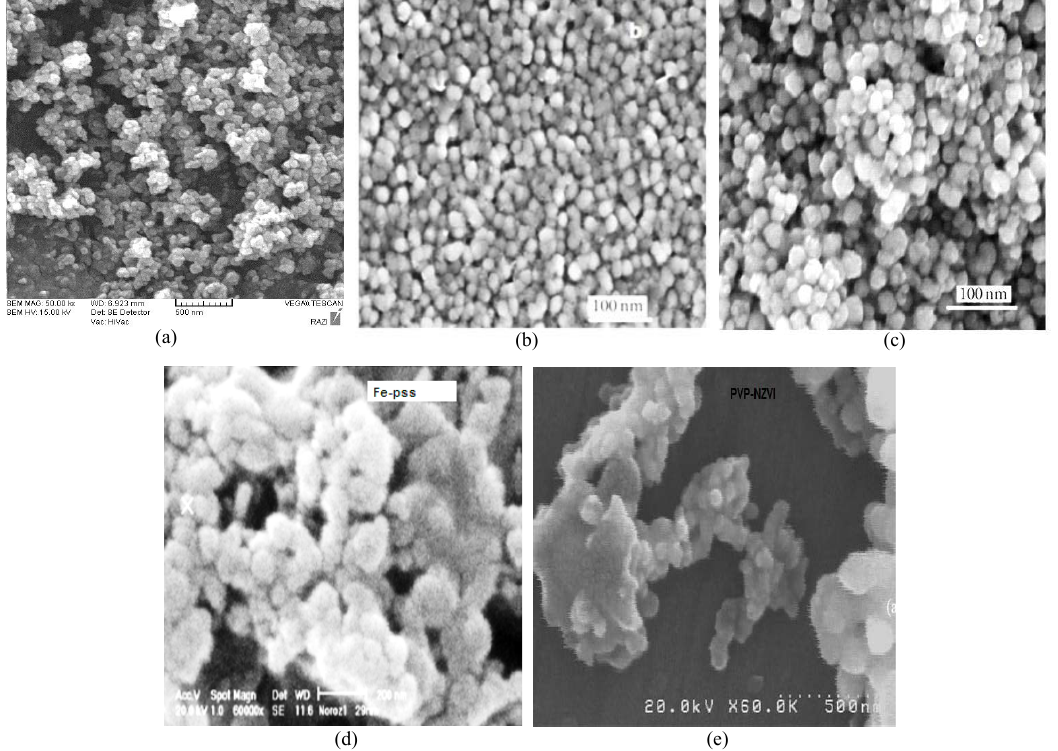
Fig.1. SEM image of (a) bare ZVINs , (b)PAM-ZVINs, (c) GG-ZVINs, (d) PSS-ZVINs, (e) PVP-ZVINs